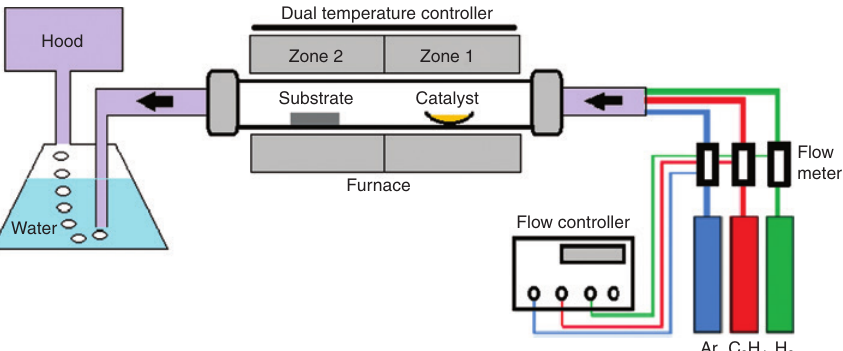
Figure 2: Schematic of a CVD reactor used in the current research